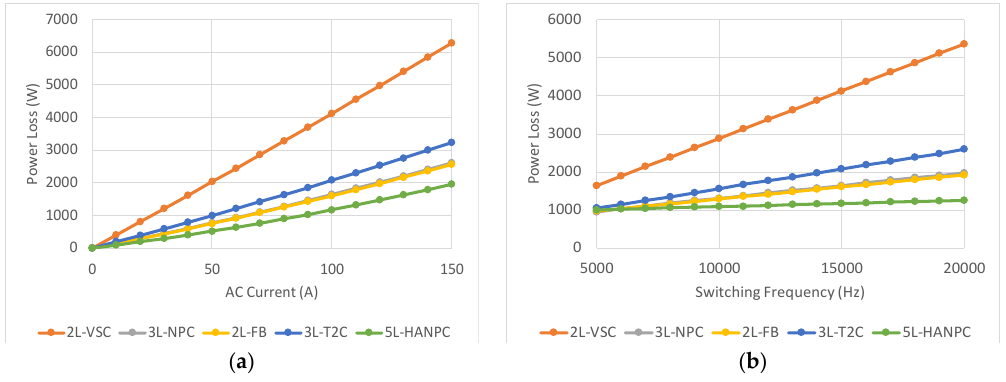
Figure 4. Loss performance comparison in the inverter mode (power factor = 0.76, M = 0.94) under different conditions: ( a ) varied AC currents and a fixed switching frequency ( f s = 15 kHz); and ( b ) varied switching frequencies and a fixed AC current ( I ac = 100 A).